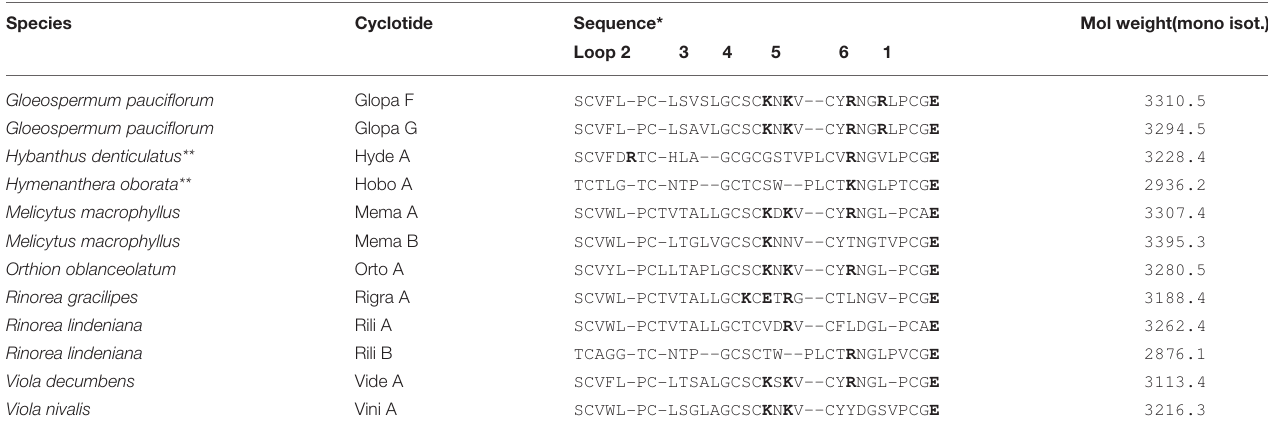
TABLE 1 | Alignment of the isolated cyclotides of nine species in six different genera in the Violaceae, but the species are given as reported on herbarium sheets.